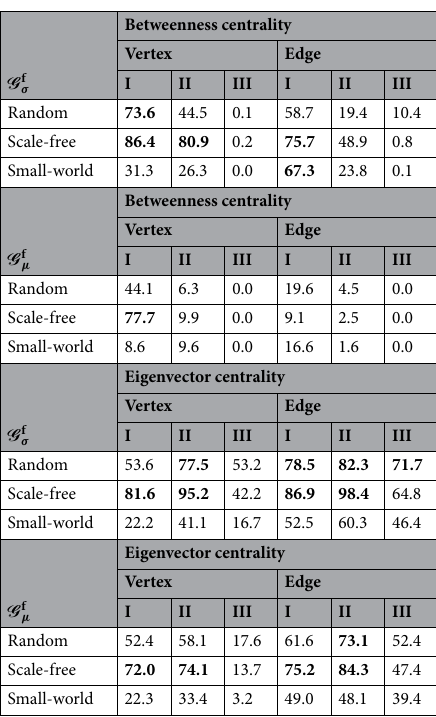
Table 2. Percentage of pairs of structural and functional networks for which the rank orders of vertex resp. edge centrality values are positively correlated (Spearman’s ρ ; p < 0.05 ). Rankings are based on either f betweenness centrality or eigenvector centrality. Upper part: functional networks G σ derived with maximum- f lag cross correlation; lower part: G µ derived with mutual information . The pairs are broken down according to the regimes of low (I), of intermediate (II), and of high coupling strengths (III). We highlight cases in bold for which percentages exceed 66.6%